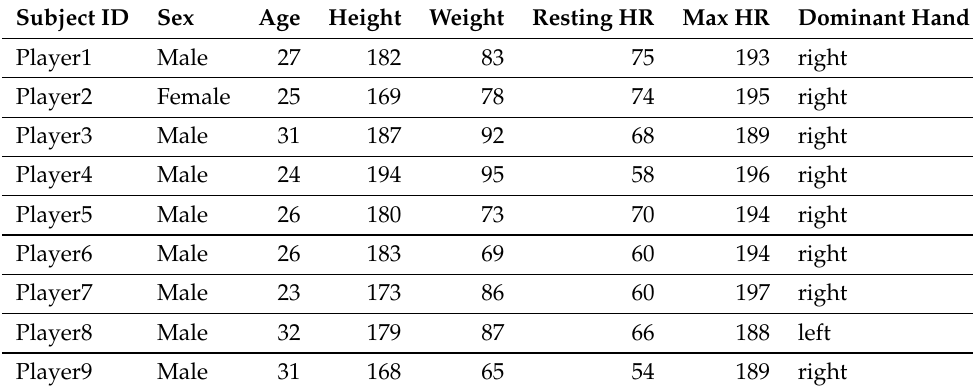
Table 1. PAMAP2 table, with age expressed in years, height in cm, weight in kg, heart rates in